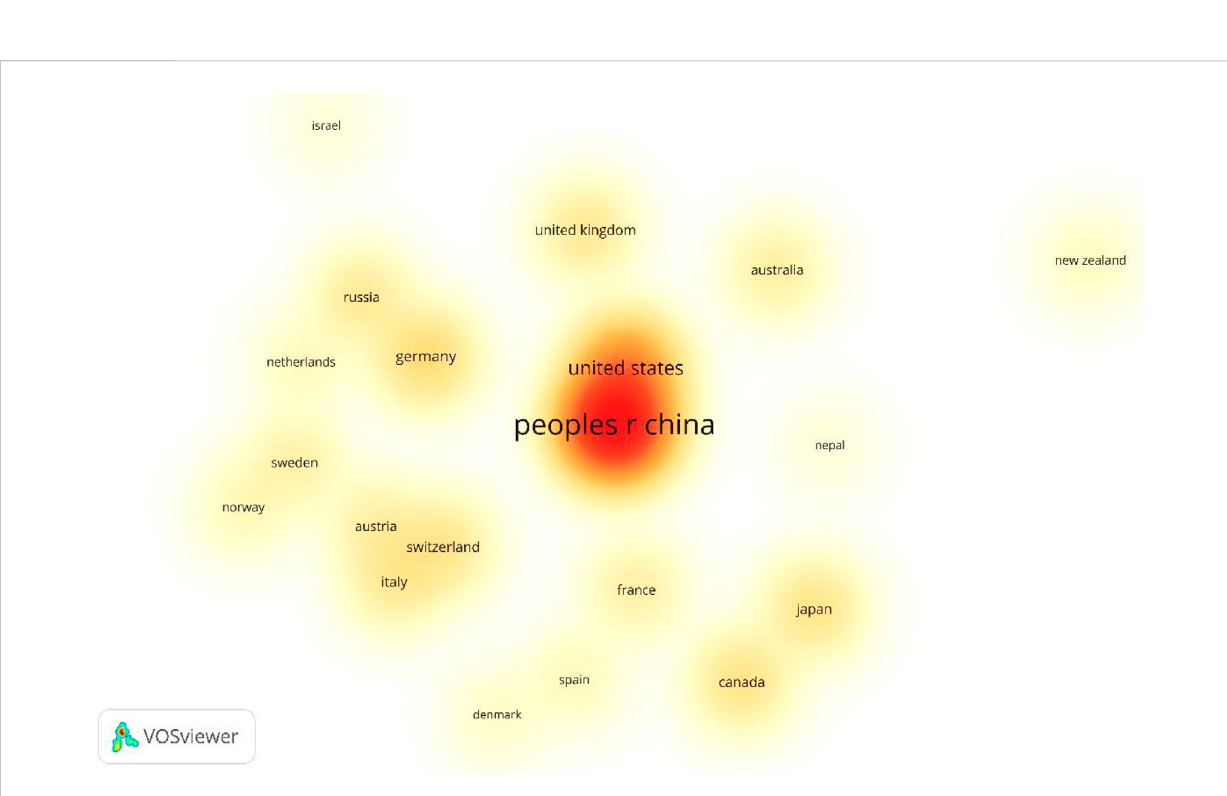
FIGURE 4 Top 20 countries/regions in terms of cooperation density in alpine meadow